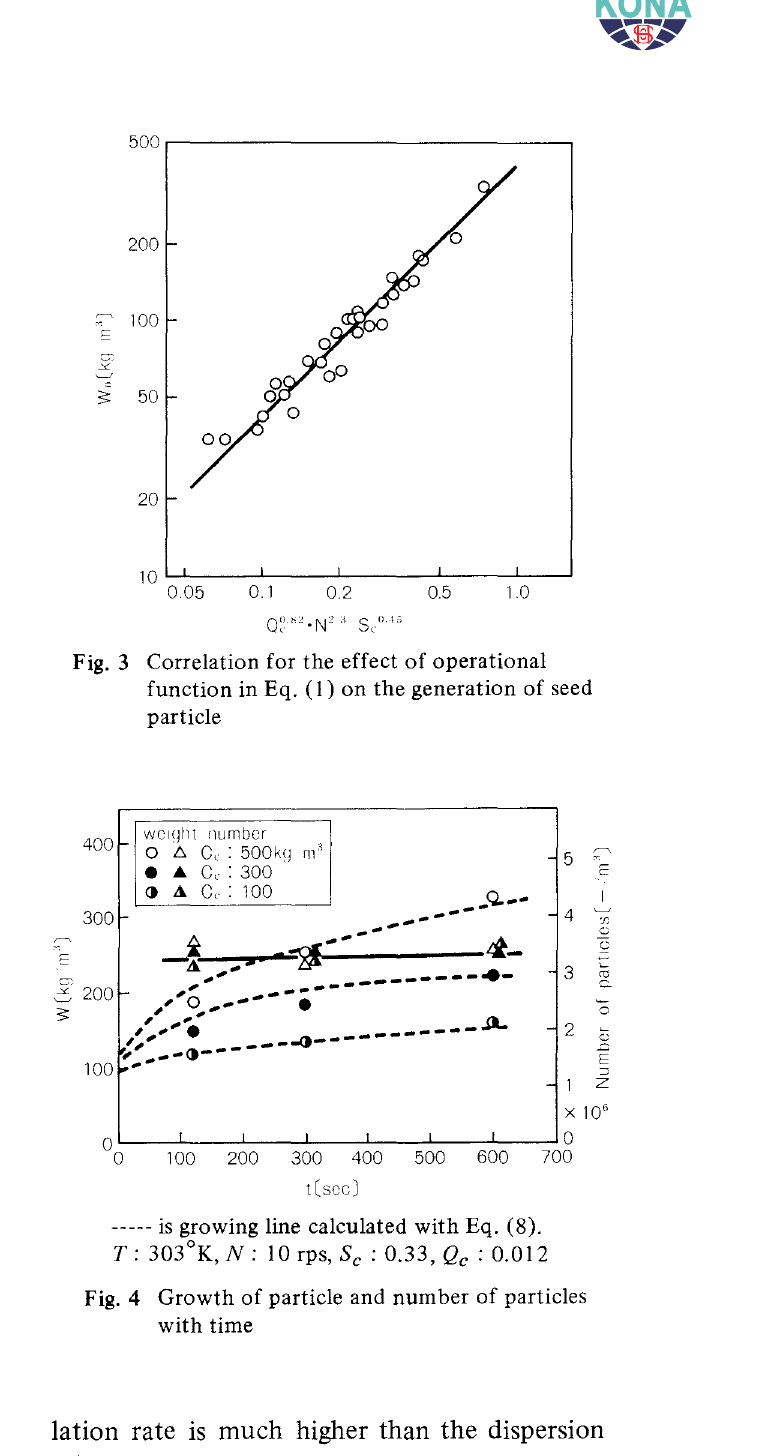
Fig. 4 Growth of particle and number of particles with